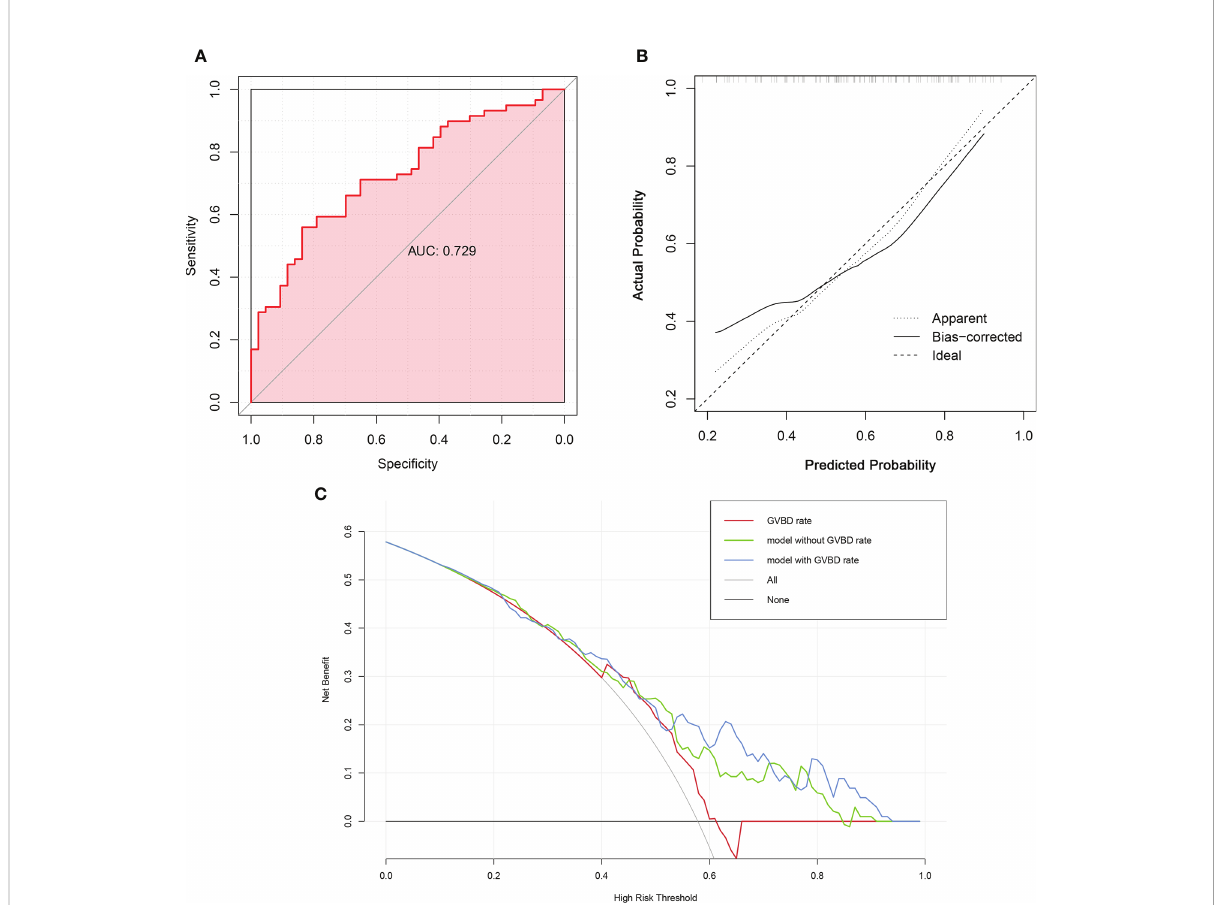
FIGURE 2 The validation of the multivariate logistic regression model. (A) . The discrimination was evaluated using the area under curve (AUC) of the receiver operating characteristic curve (ROC). (B) . The calibration was measured using calibration curve. The x -axis was the predicted probability of pregnancy, and the y -axis indicated the actual observed probability of pregnancy. (C) . Decision curve analyses of logistic regression models. The net bene fi t over a spectrum of probability thresholds was calculated to illustrate the accuracy of three models using decision curve analyses. The red curve represented a logistic regression model using GVBD rate only. The green line assumes the nomogram without GVBD rate, whereas the blue one plotted the nomogram with GVBD